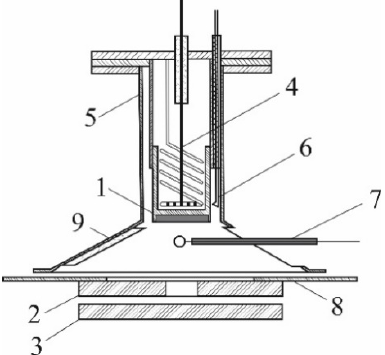
Figure 2. Flowchart of the device with discharge channel narrowing: cathode (1), main anode (2), external control electrode (3), heater (4), heat shield (5), cathode micro thermocouple (6), probe (7), protection alundum insulators (8), and lateral conductive shield (9).